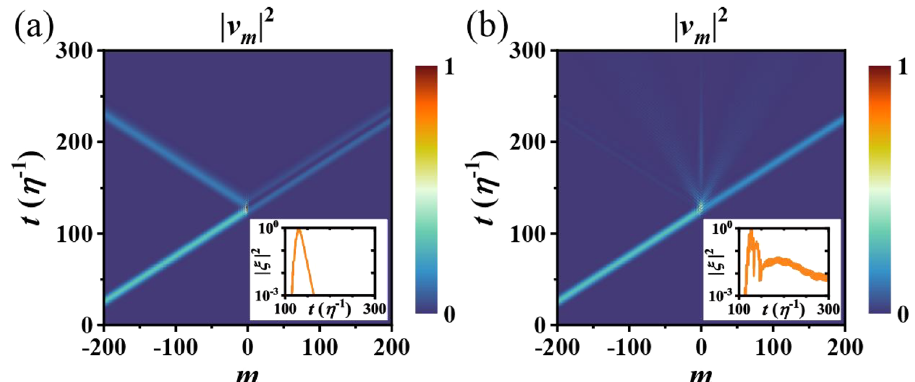
Fig. 2 The evolution of photonic states. Normalized probability distributions of photon in different resonators versus the time, when ( a ) Ω = 3 η and ( b ) Ω = 2.05 η , respectively. The insets show the corresponding normalized atomic excitation probability in the logarithm